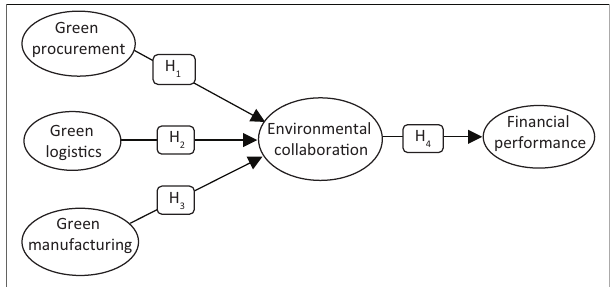
FIGURE 1: Hypothetical model of the association between green supply chain management, environmental collaboration and financial